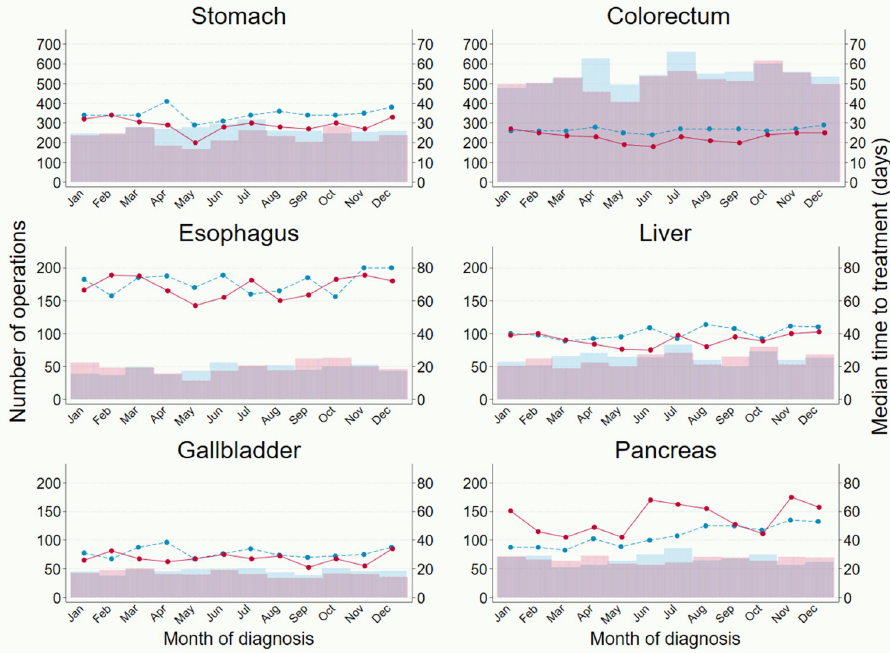
Fig 2. Number of operations and median time to operation for six digestive cancers. Bar graphs indicate number of operations (left axis: blue 2019, pink 2020) and line graphs indicate monthly median time in days from diagnosis to operation (right axis: blue dash 2019, red solid 2020). Note that both the right and left axes are different for stomach and colorectal cancer.